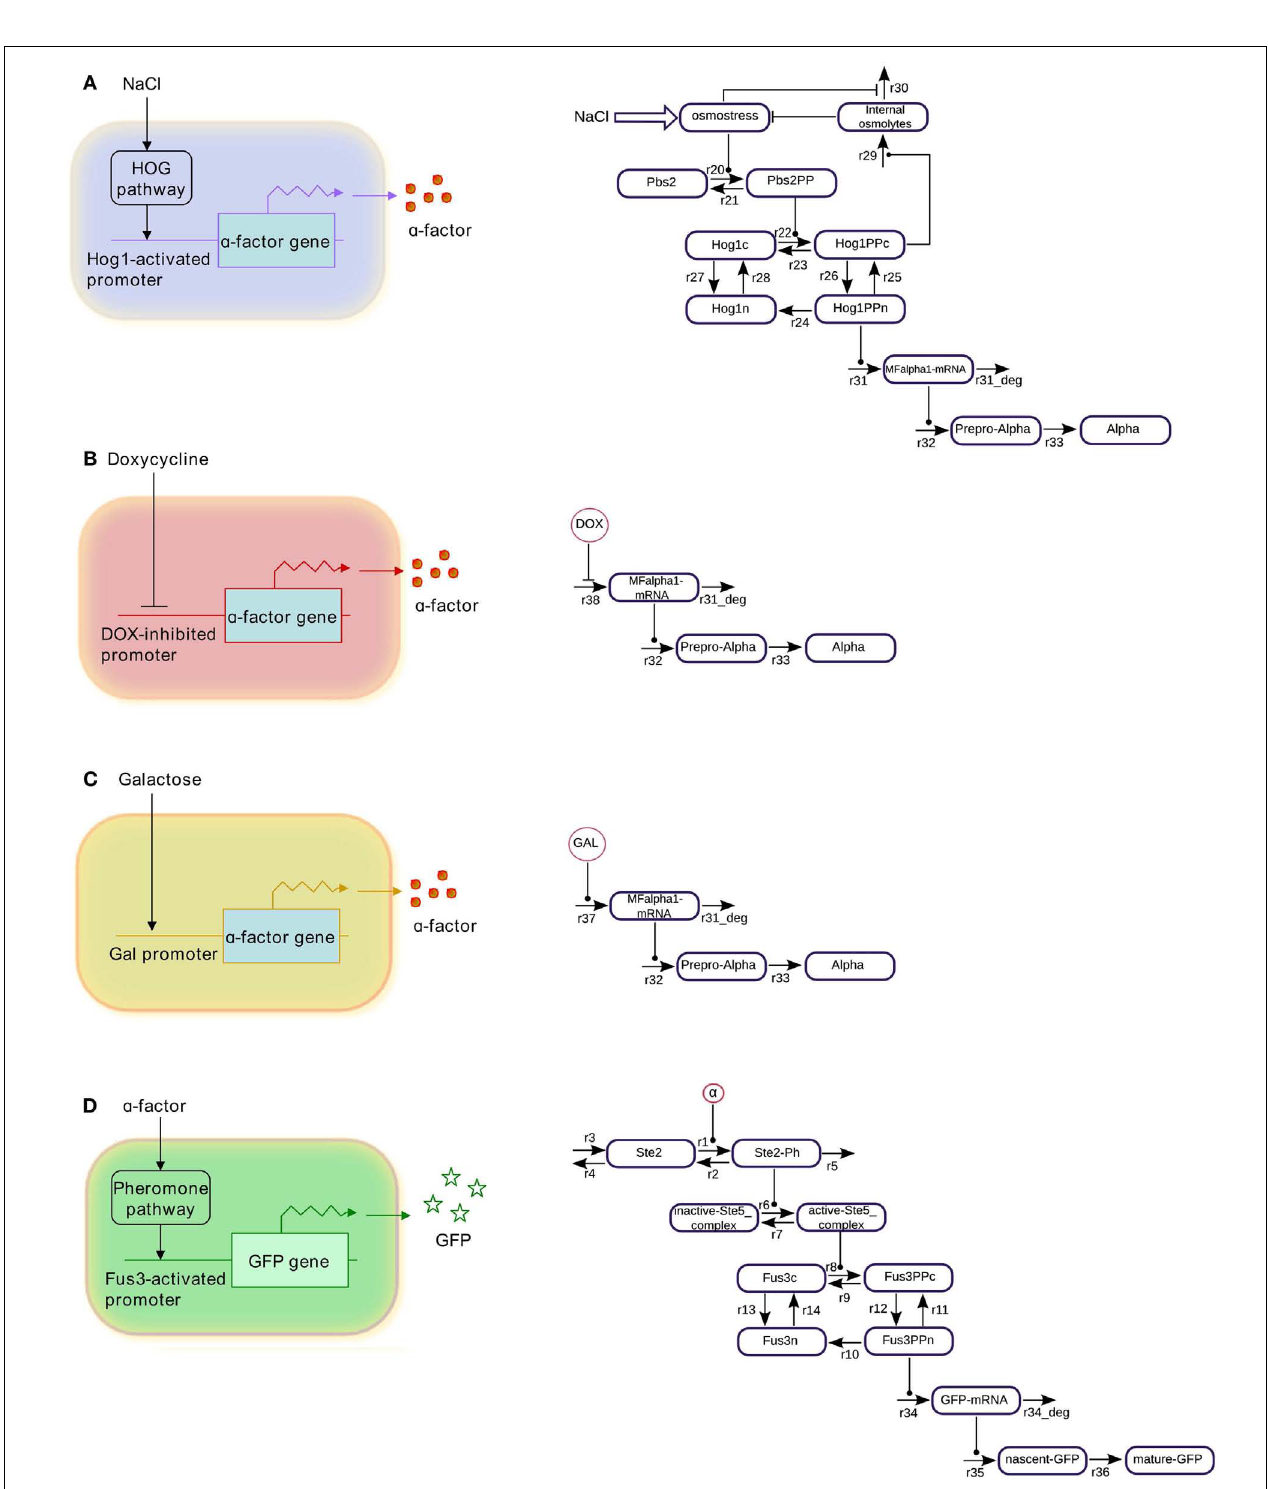
FIGURE 1 | Schematic representations and wiring graphs of the modeled cells. (A) Salt-cell, (B) dox-cell, (C) gal-cell, (D) reporter cell.